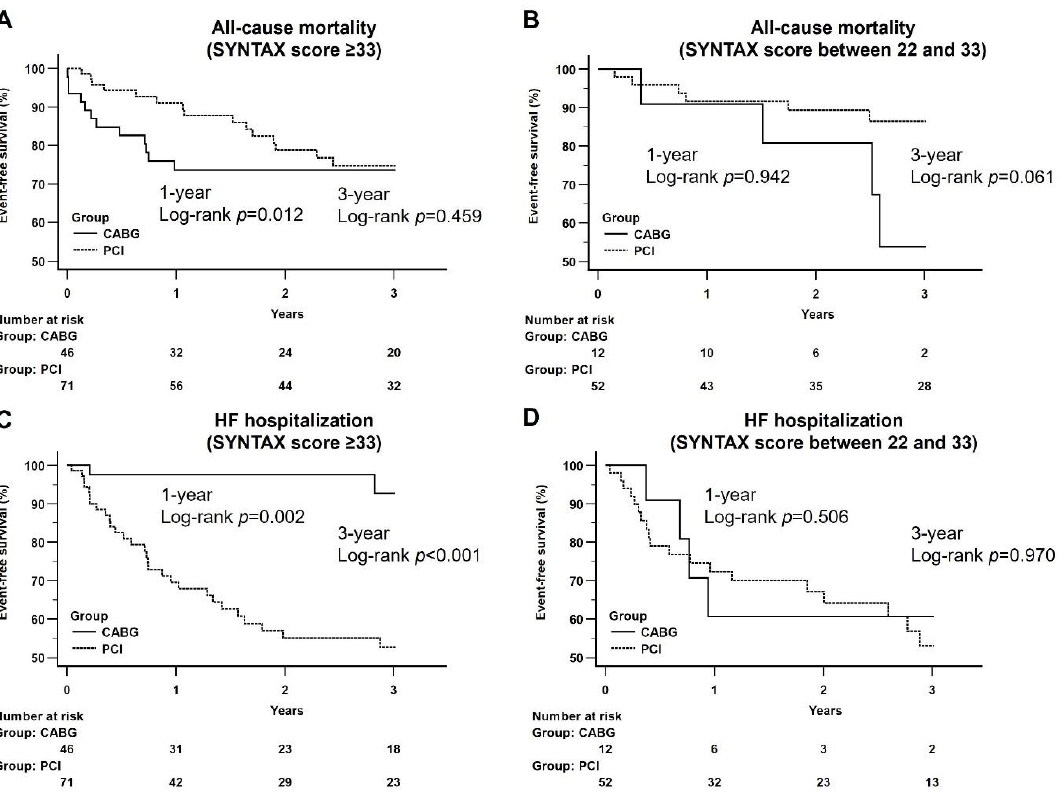
Figure 3. Kaplan – Meier curves of all-cause mortality and heart failure hospitalization at follow-up period between CABG and PCI groups by a different range of SYNTAX score. ( A ) CABG vs. PCI (SYNTAX score ≥ 33): A better survival outcome was noted at the one-year follow-up period (log- rank p = 0.012) and did not differ at the three-year follow-up period between CABG and PCI groups (log-rank p = 0.459); ( B ) CABG vs. PCI (SYNTAX score between 22 and 33): There was no significant difference at the one-year and three-year follow-up period between CABG and PCI groups.; ( C ) CABG vs. PCI (SYNTAX score ≥ 33): CABG group had a significantly lower incidence of HF hospi- talization at the one-year (log-rank p = 0.002) and three-year (log-rank p < 0.001) follow-up period; ( D ) CABG vs. PCI (SYNTAX score between 22 and 33): There was no significant difference at the one-year and three-year follow-up period between CABG and PCI groups.